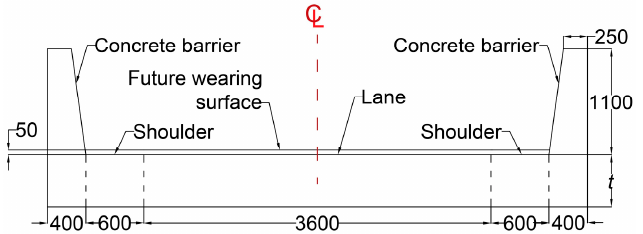
Figure 2. Cross-section for case study bridge with one lane. All dimensions are in millimeters. To design the reinforcement, we used 500 MPa steel and concrete with a compressive strength of 35 MPa. The length, L , is varied from 7.5 to 15 m in increments of 2.5 m, representing a typical range of lengths used for solid slab bridges. The width is varied from 5.6 (one lane) to 16.4 m (four lanes) in increments of 3.6 m (one design lane). Finally, the skew angle is varied from 0 ◦ to 60 ◦ in increments of 15 ◦ , representing a typical range of skew angles used for skewed solid slab bridges. In the Netherlands, skew slab bridges of approximately 15 ◦ , 30 ◦ , 45 ◦ , and 60 ◦ skew angles represent roughly 56%, 26%, 14%, and